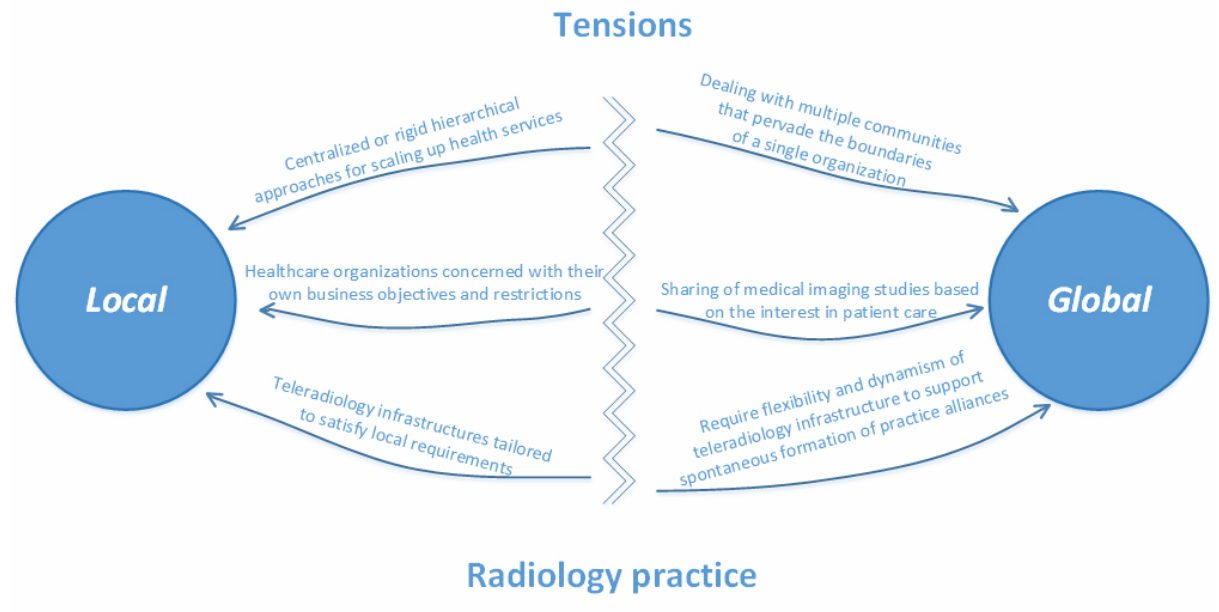
Figure 1. Polarization due to tensions between local and global demands for radiology